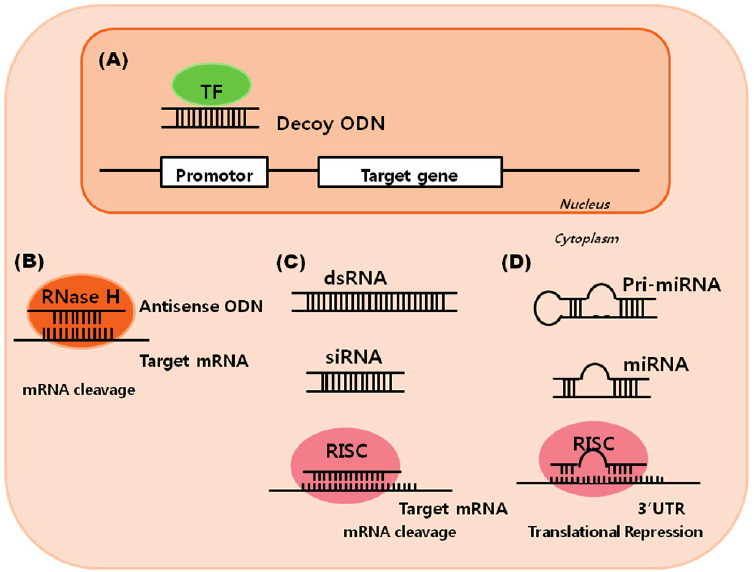
Figure 1. Small-nucleic-acid-based therapeutic strategies. ( A ) Double-stranded decoy oligodeoxynucleotides (ODNs) block the binding of transcription factors (TFs) with the promoter regions of target genes and inhibits specific gene expression at the pretranscriptional level; ( B ) Antisense ODNs specifically hybridize with their target messenger RNA (mRNA), which activates ribonuclease H (RNase H) that can degrade the target mRNA; ( C ) Small interfering RNA (siRNA) incorporate into an RNA-induced silencing complex (RISC) forming a perfect duplex with their target mRNA site, which leads to a specific cleavage of target mRNA; ( D ) microRNAs (miRNAs), which are small-non-protein-coding RNAs, are generated as primary RNA precursors of miRNAs (pri-miRNA) in the nucleus, and bind to the target 3 ʹ untranslated (UTR) region. The regulation of gene expression at the posttranscriptional level occurs either by inhibiting the translation of protein from mRNA or by promoting the degradation of mRNA. dsRNA: double-stranded